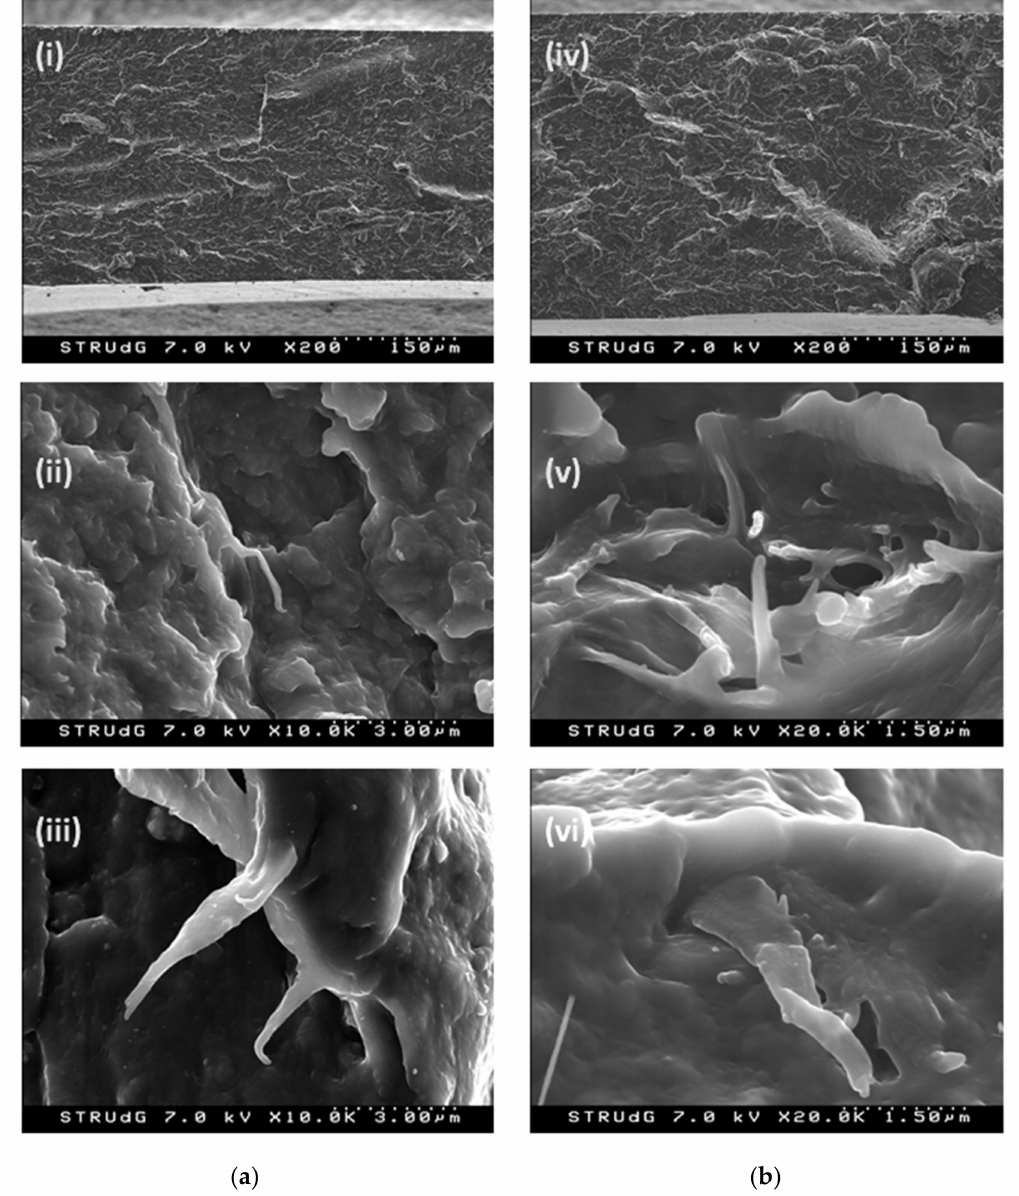
Figure 8. SEM micrographs of ( a ) 5 wt % and ( b ) 25 wt % PA/CNF